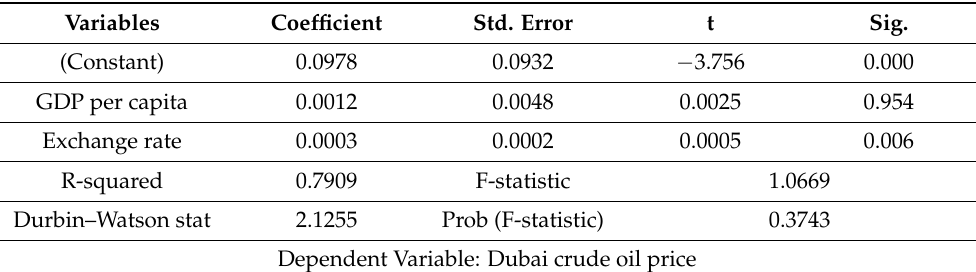
Table 6. The Results of OLS Regression Analysis for Analyzing the Impact of Dubai Crude Oil Price and National Income during the period from 1990 to 2020.